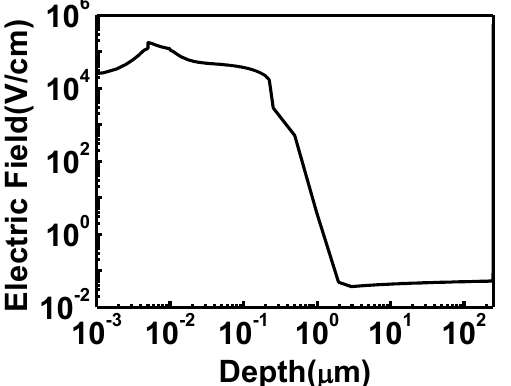
Figure 5. The electric field distribution within the HIT structure. The electric field is largest within the top intrinsic a-Si:H